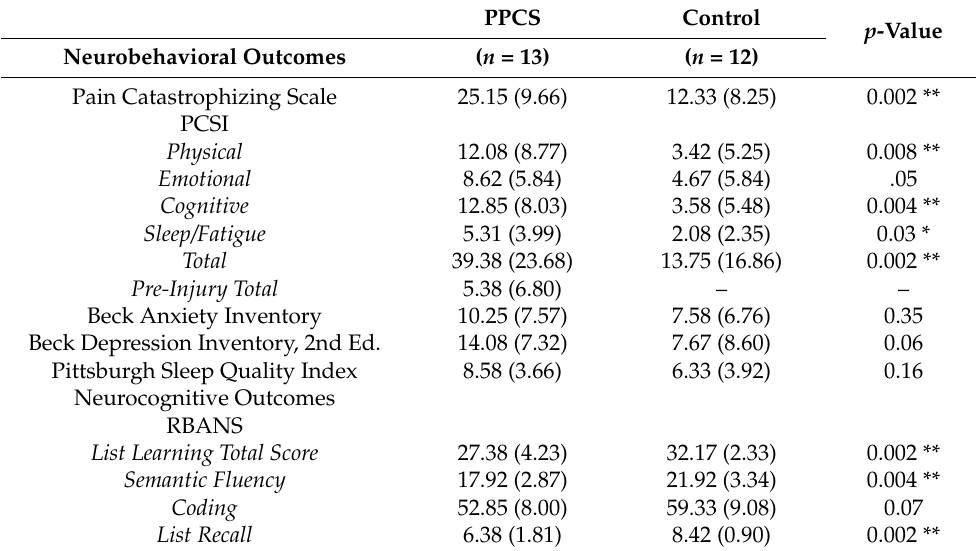
Table 2. Neurobehavioral outcomes by